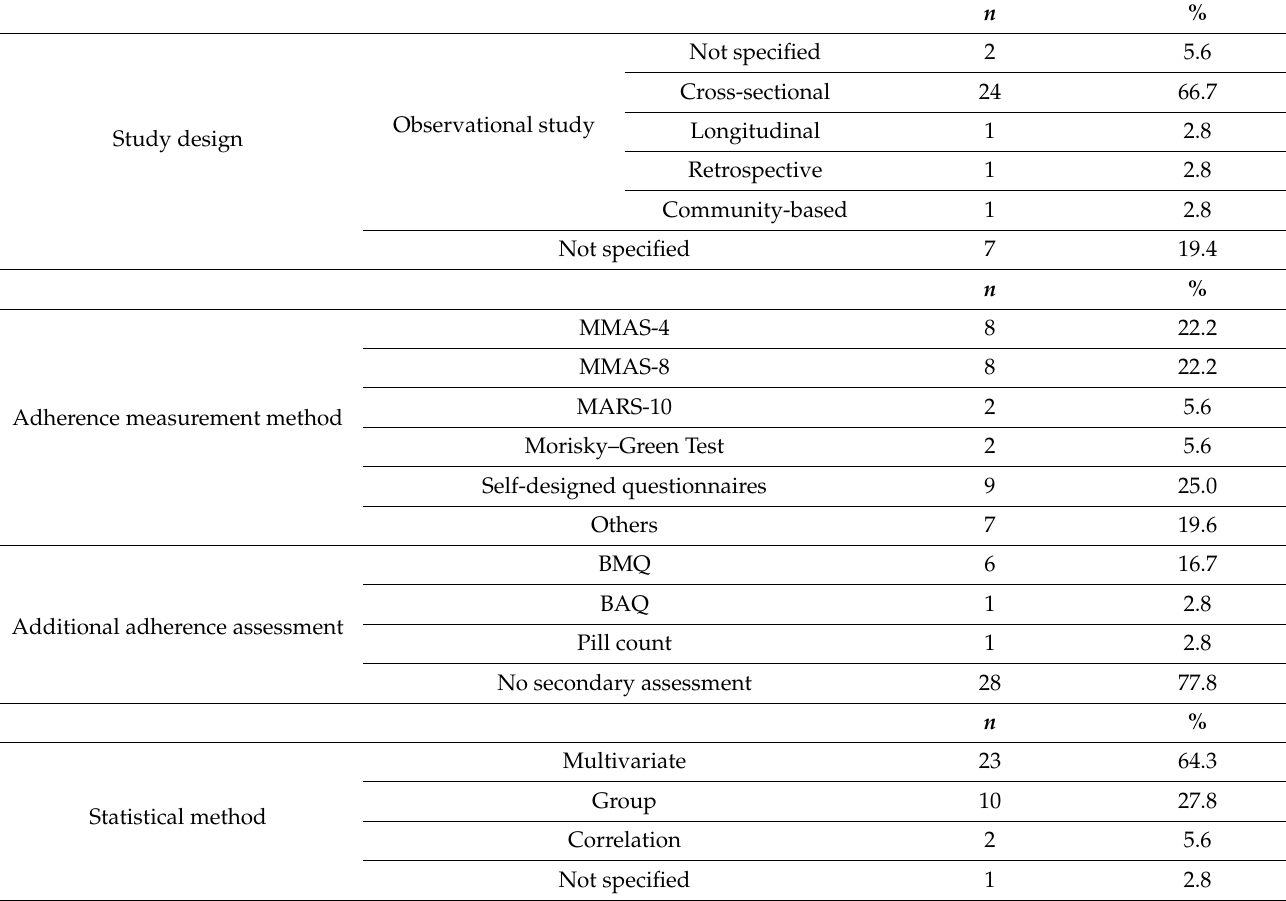
Table 1. Overview of selected study designs and methods of measuring adherence.